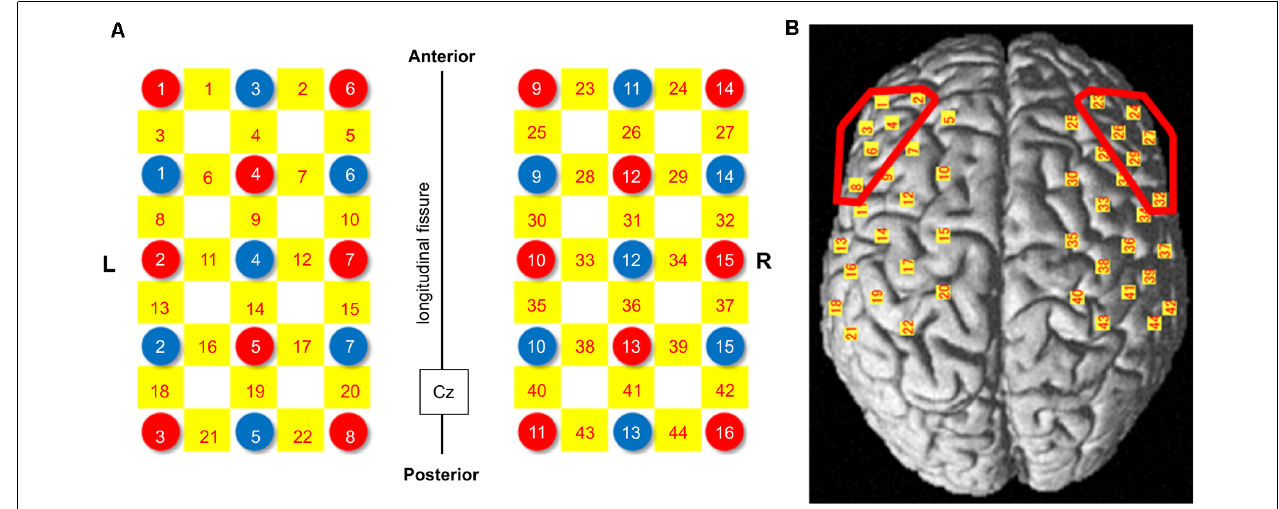
FIGURE 2 | NIRS probe arrangement (Left 3 × 5, Right 3 × 5). (A) Illuminators and detectors are shown as red and blue circles, respectively, and channels are shown as yellow squares. The Cz was defined according to the international 10-20 placement system. (B) The channel positions are shown on the cortical surface. Red-colored circles show the dorsolateral prefrontal cortex (DLPFC) area. NIRS: near-infrared spectroscopy.